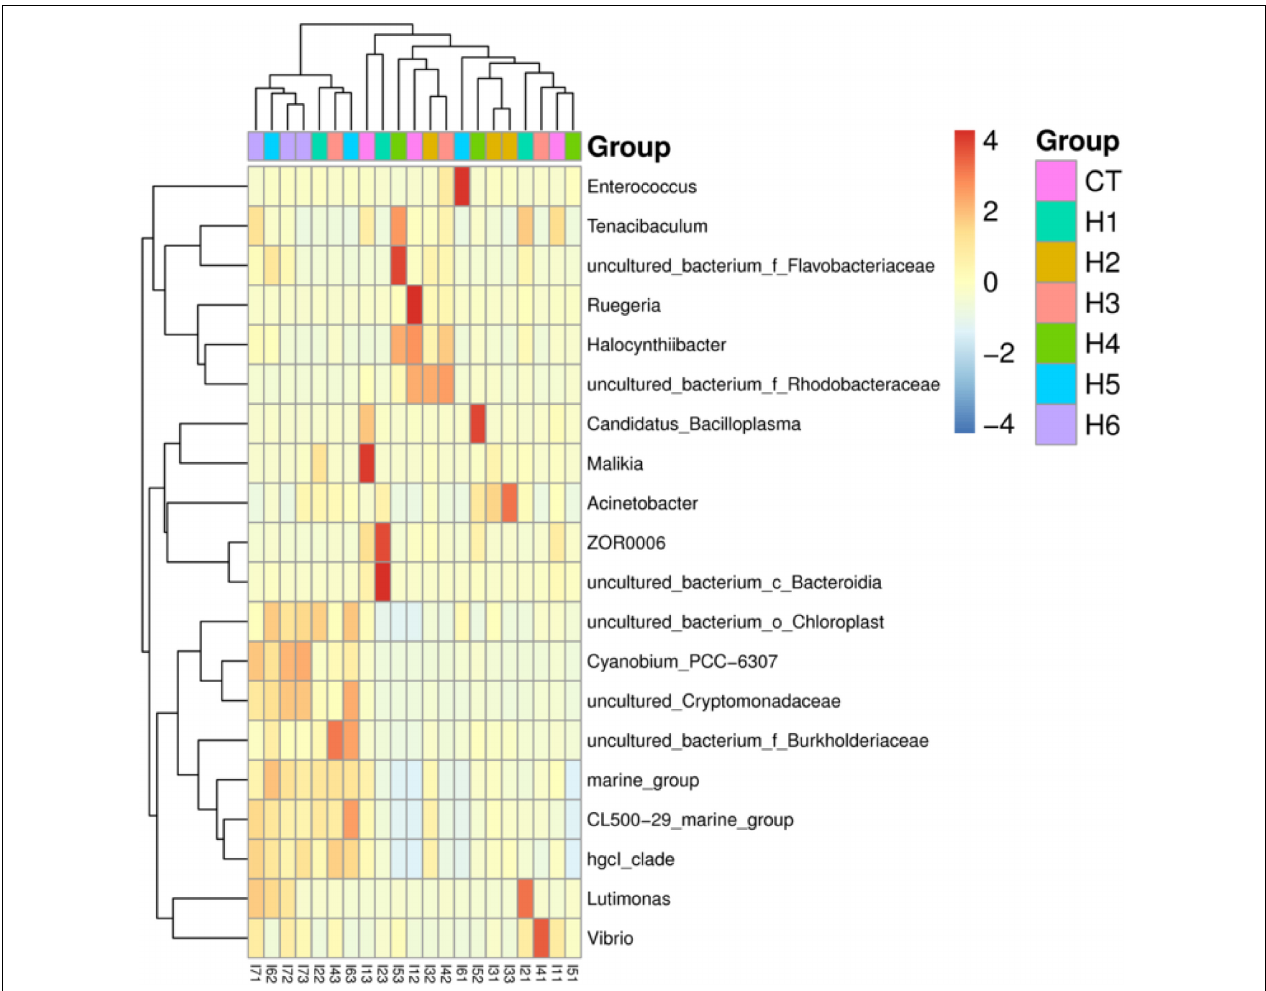
FIGURE 5 | Heatmap of the abundance of intestinal bacteria at the genus level of juvenile pearl gentian hybrid grouper fed with different levels of HFP. Color intensity indicates the relative enrichment of